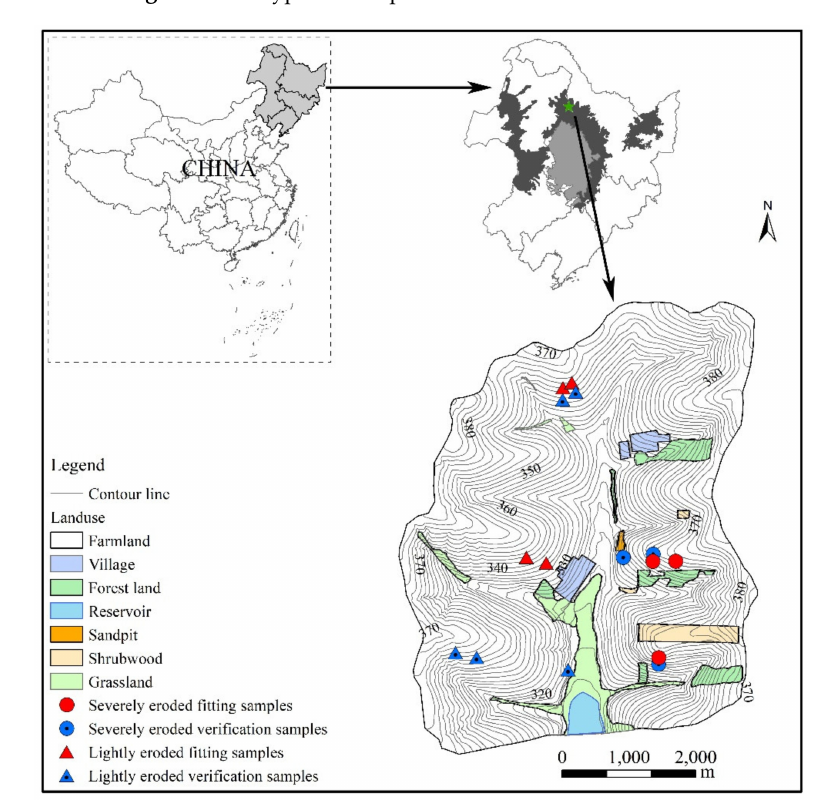
Figure 2. The distribution of field